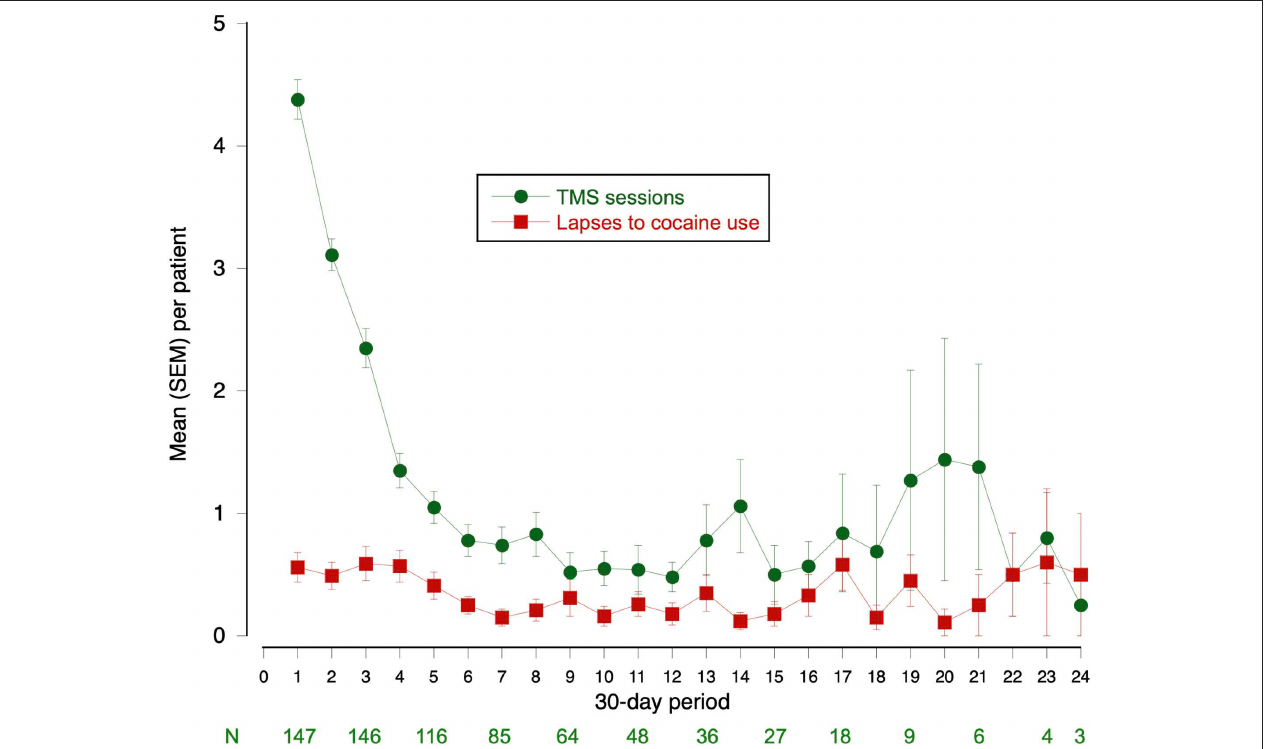
FIGURE 3 | Maintenance rTMS sessions and lapses in closely followed subsample, month by month. This is a collapsed view of data from Figure 2 . Green line: Mean (SEM) number of rTMS sessions per patient. Red line: Mean (SEM) number of cocaine lapses per